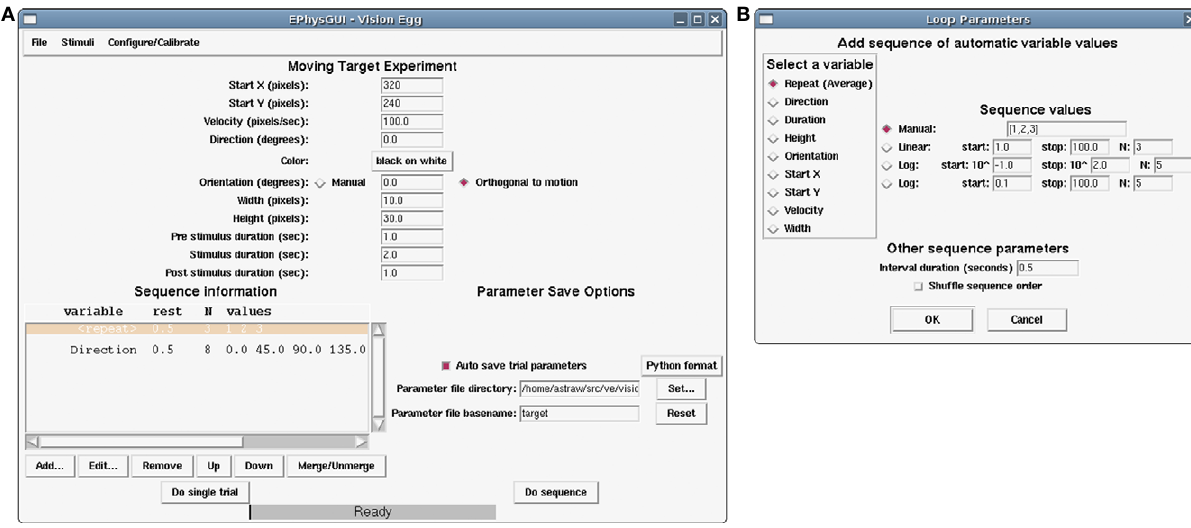
Figure 4 | Screenshot of electrophysiology-oriented GUI application included with the Vision Egg called ephys.gui.pyw and described in Section “High-level Software Overview: An Application for Electrophysiology.” (A) Main window shows parameters for repeated presentations of a stimulus with the possibility of automatically sequencing over variables. All settings can be saved and loaded from disk. (B) The loop parameters window allows control of